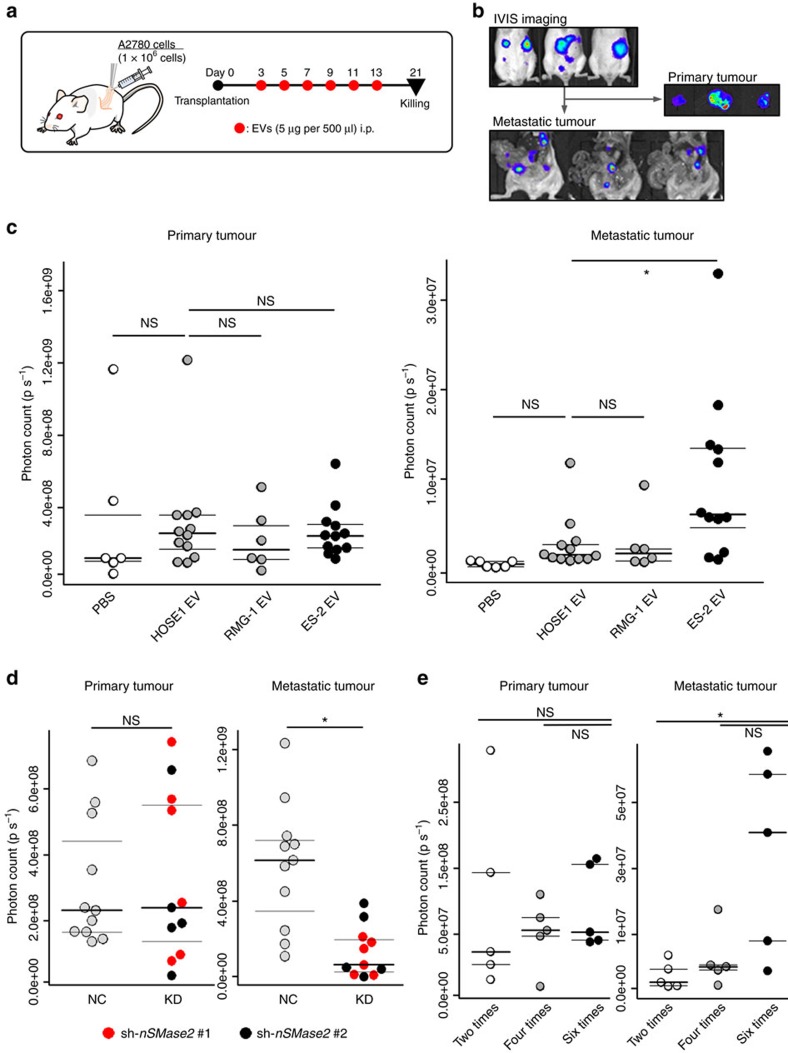
EVs derived from highly metastatic ovarian cancer cells promote peritoneal dissemination in vivo.(a) Schematic protocol for investigating the EVs in peritoneal dissemination. Orthotopic mouse models were established with A2780 cells. ES-2 EVs, RMG-1 EVs, HOSE1 EVs and PBS were injected i.p. from day 3 to 13, every other day, 6 times. The mice were killed on day 21. This protocol was applied in c. (b) Representative bioluminescence images of orthotopic mouse models at day 21. The upper images were captured from outside the bodies using the IVIS. The right-middle images show dissected primary tumours. The lower images indicate the metastatic tumours in the peritoneal cavity after the primary tumours in these mice were already removed. (c) Distribution of photon count in the dissected primary tumour (left) and the peritoneal metastatic tumours (right). The mice were treated with three types of EVs and PBS as described in a. n=12; ES-2 EVs, 6; RMG-1 EVs, 12; HOSE1 EVs and 6; PBS. Dunnett's test (*P<0.05 and NS, no significance). (d) Distribution of photon count in the dissected primary tumours (left) and the peritoneal metastatic tumours (right) using nSMase2 KD cells and negative control (NC) cells. The orthotopic mouse model was established by injection with ES-2 cells and the cells were transfected with the two different sequences of nSMase2 shRNA vector (KD; 1 and 2) or control vector (NC). The mice were killed at day 14. KD, knockdown of nSMase2; NC, negative control. Student's t-test (*P<0.05 and NS, no significance). (e) Dose dependency of ES-2 EVs on promoting peritoneal dissemination. Orthotopic mouse models were established with A2780 cells. ES-2 EVs were injected i.p. from day 3 and every other day thereafter. The names of the groups indicated how many times the EVs were injected. The mice were killed on day 21. Distribution of photon count in the dissected primary tumour (left) and the peritoneal metastatic tumours (right). n=5; 2 times, n=5; 4 times, n=5; 6 times. Dunnett's test (*P<0.05 and NS, no significance).